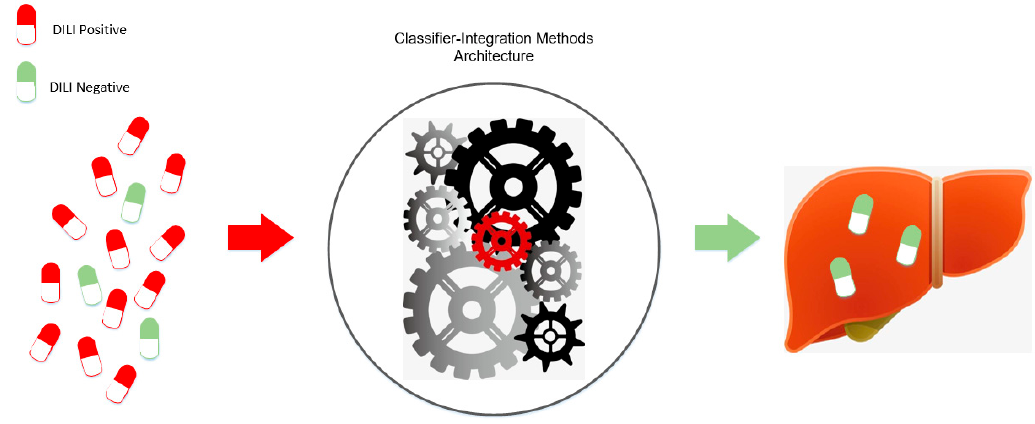
Figure 1. Concept map of drug-induced liver injury (DILI) modeling Figure 1. C oncept map of drug-induced liver injury (DILI) modeling process.